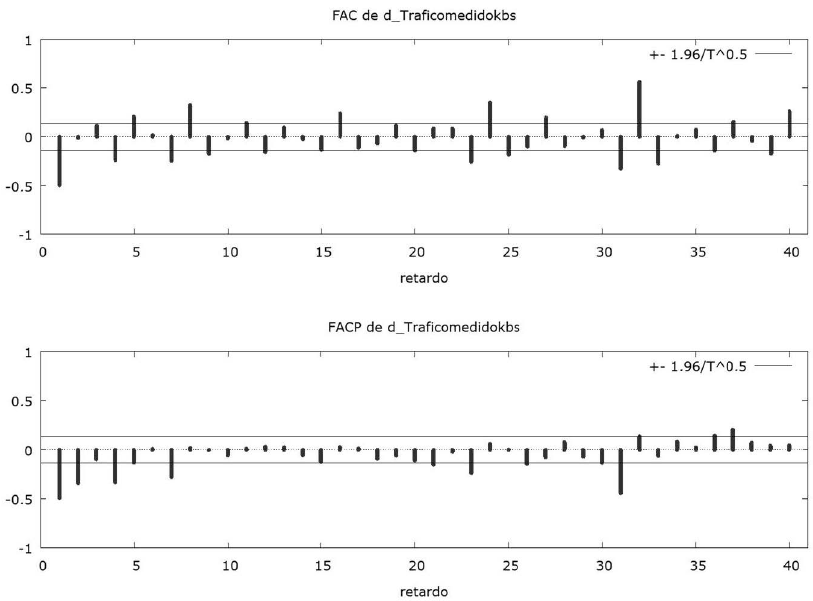
Figure 6. ACF (Autocorrelation function) and PACF (Partial autocorrelation function).